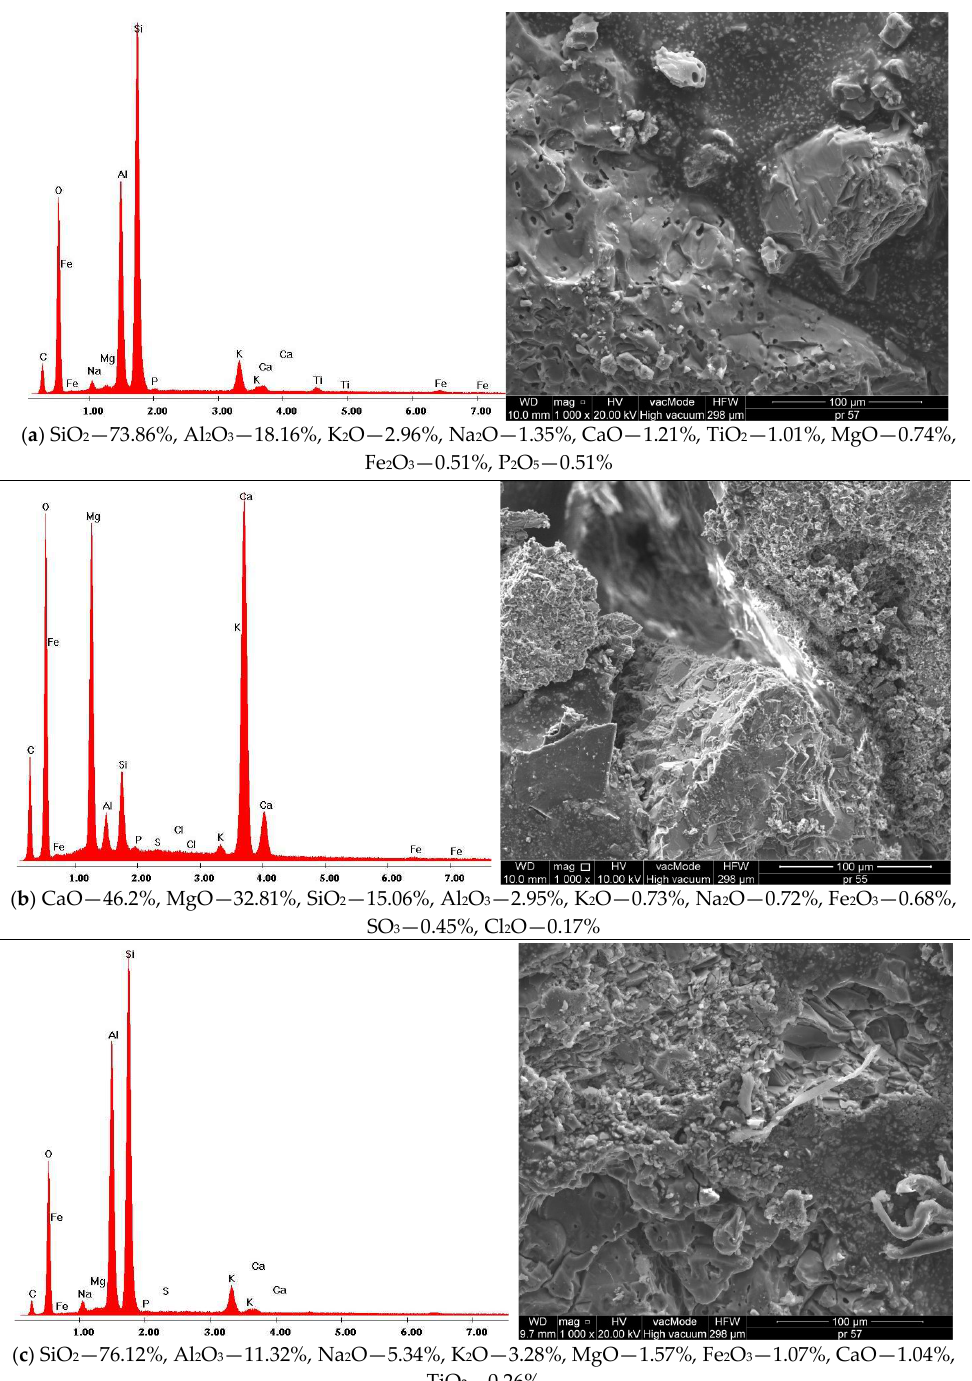
Figure 7. SEM Microstructure of MAM, results of the elemental analysis in EDS microarea: ( a ) WC-1, ( b ) WC-4, ( c )